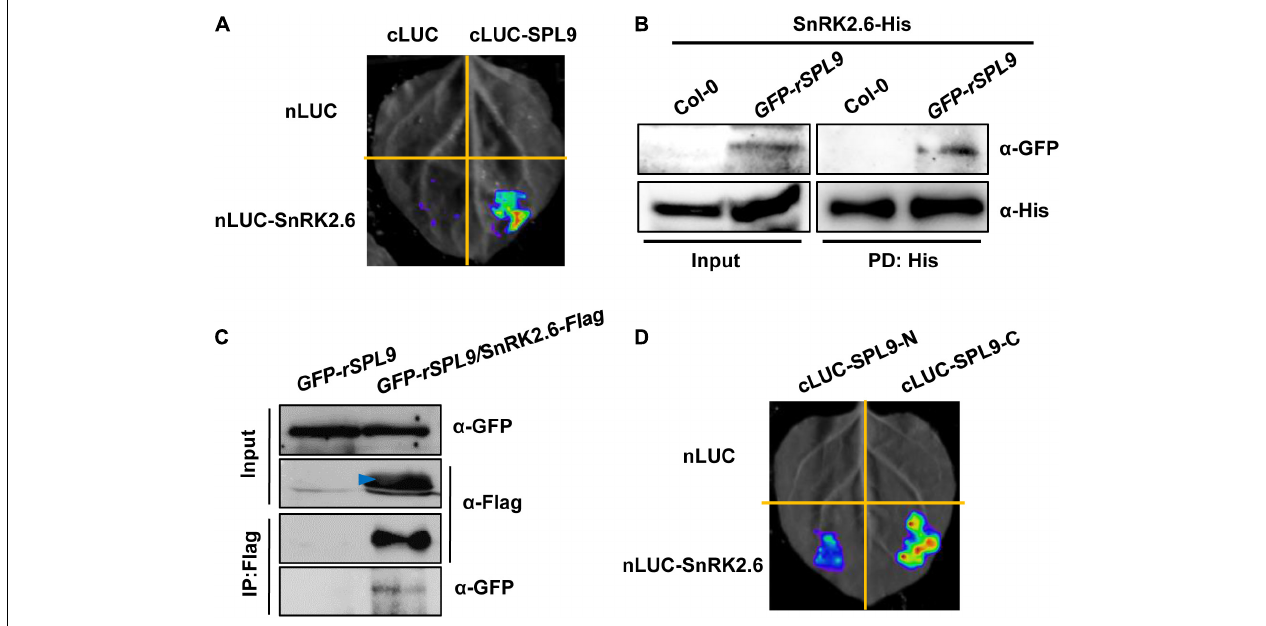
FIGURE 4 | SnRK2.6 directly interacts with SPL9. (A) LCI assays showing the interaction between SnRK2.6 and SPL9 in N. benthamiana leaves. Empty vectors were used as negative controls. (B) Semi -in vivo pull-down assays showing the interaction of SnRK2.6 and SPL9. Anti-GFP and anti-His antibodies were used for immunoblotting assays. PD, pull down. (C) Co-IP assays showing that SnRK2.6 physically interacts with SPL9 in vivo . Total proteins were analyzed by immunoblotting with anti-Flag and anti-GFP antibodies. Arrowhead indicates specific band. (D) LCI assays showing the interaction between the truncated SPL9 versions and full-length